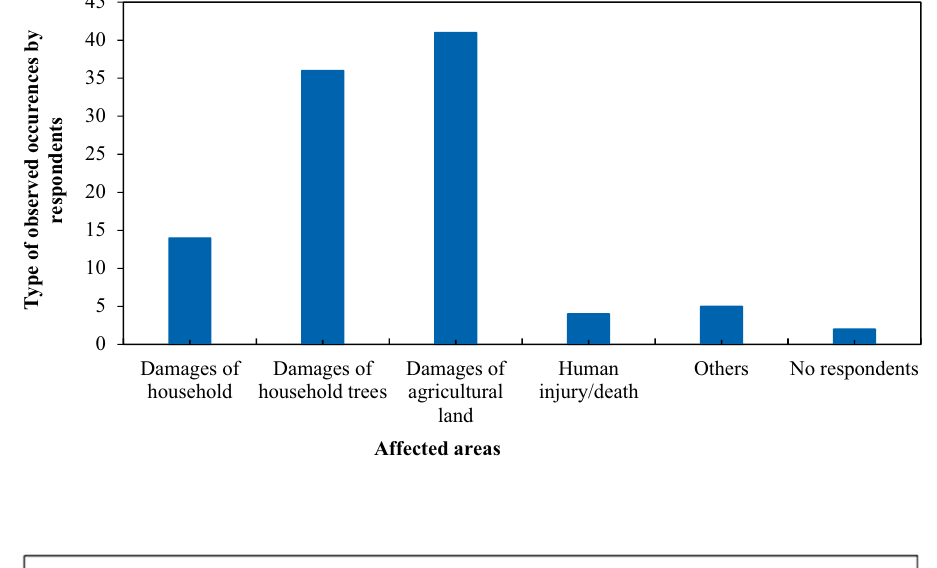
Fig. 7 Human–elephant con- flict risk map in Fashiakhali for- est reserve, Cox’s Bazar. (Image source: Google Earth